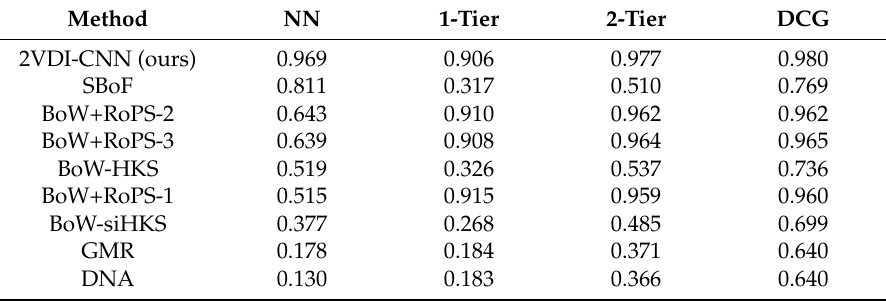
Table 4. Retrieval performance for the range data challenge, sorted decreasingly by NN score. Best results are reported in bold.